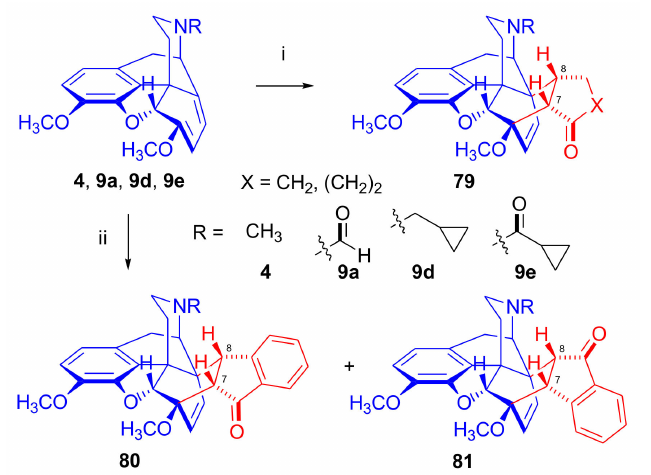
Figure 25. Diels–Alder reactions of morphinan-6,8-dienes with cycloalkenones and with 1-indenone. Reagents and conditions : (i): 2-cyclopenten-1-one or 2-cyclohexen-1-one, (A) toluene, 130 ◦ C, sealed tube, 24 h; or (B) LiBF 4 , neat, room temperature, 7–28 days, (ii): 2-( p -chlorophenylsulfinyl)-1-indanone, toluene, reflux, 9–30